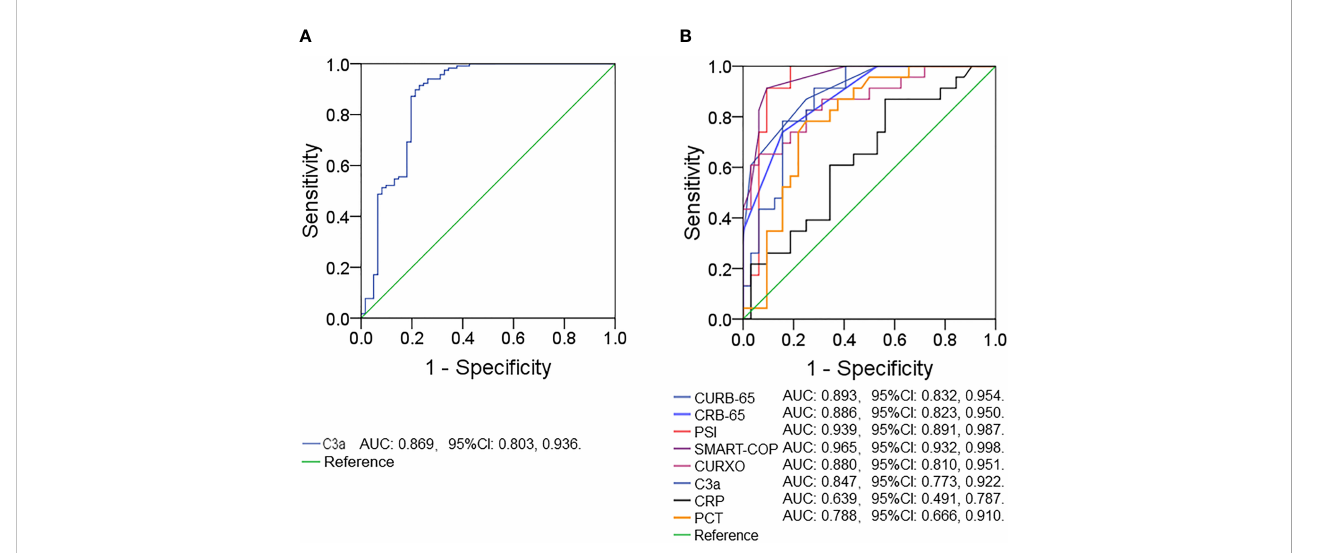
FIGURE 2 Receiver operating characteristic curves for different predictive indexes on admission. (A) ROC curve was used to evaluate the predictive value of serum complement C3a for CAP. (B) ROC curve was used to evaluate the predictive values of different indexes (C3a, CRB-65, CURB-65, CURXO, SMART-COP, PSI, CRP, and PCT) for the CAP severity. Receiver operating characteristic,